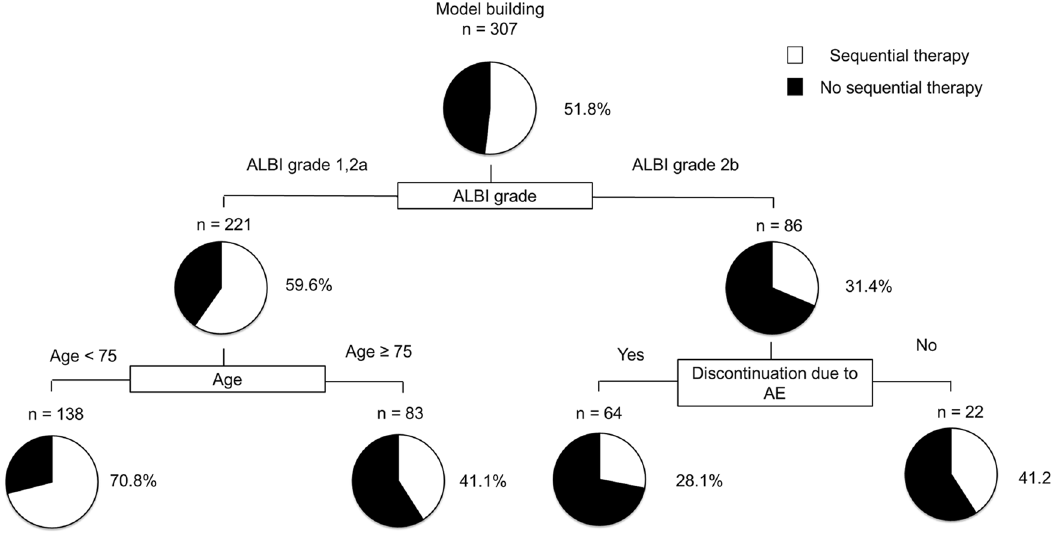
Figure 4. Profiles associated with sequential therapy. The pie graphs indicate the percentage of sequential therapy (white)/no sequential therapy (black) in each group.